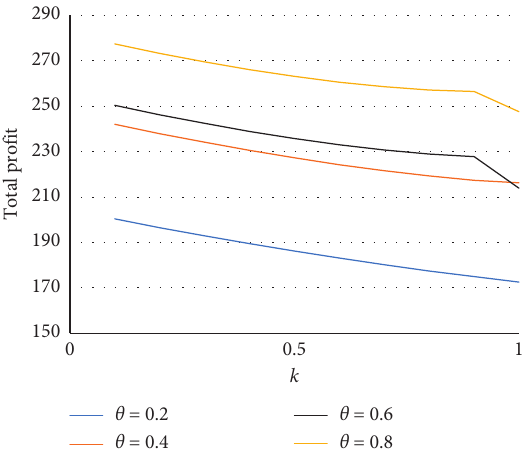
Figure 6: The influence of parameters k on total